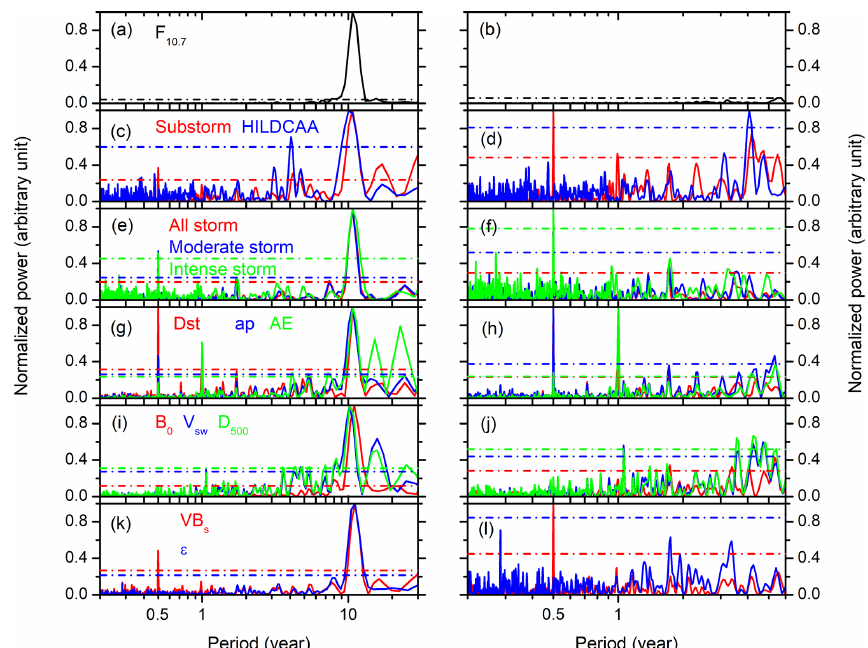
Figure 3. Lomb–Scargle periodograms. From top to bottom, the panels show the normalized power of periods for the monthly mean (a, b) so- lar F 10 . 7 flux; monthly numbers of (c, d) substorms and HILDCAAs; (e, f) all magnetic storms, moderate storms, and intense storms; monthly mean (g–h) geomagnetic indices Dst, ap, and AE; (i–j) solar wind parameters IMF B 0 , V sw , and D 500 ; and (k–l) VB s and (cid:15) parameter, re- spectively. The left panels correspond to periodograms of the original database without any filtering, while the right panels correspond to periodograms after filtering out the 11-year periodicity from the database. Horizontal dot-dashed lines in each panel indicate > 95% signif- icance levels of the corresponding parameters shown by different colors. Note that the x axes have different scaling for the left and right